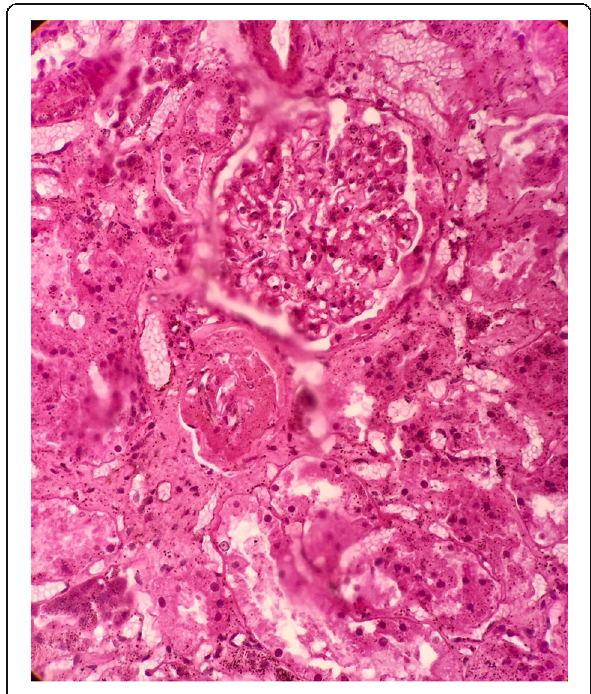
Fig. 7 Histology of kidney showing hyaline thickening of the arteriole (40×